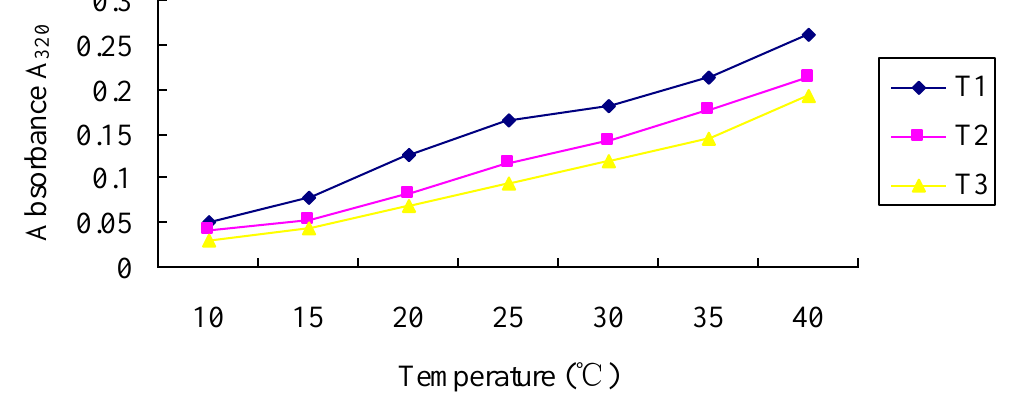
Figure 8. UV (320 nm) absorption of TMV coat-protein polymerization in vitvo treated with compound 2009104 at different time intervals T1: TMV-CP; T2: 2009104 +TMV-CP; T3: Ribavirin